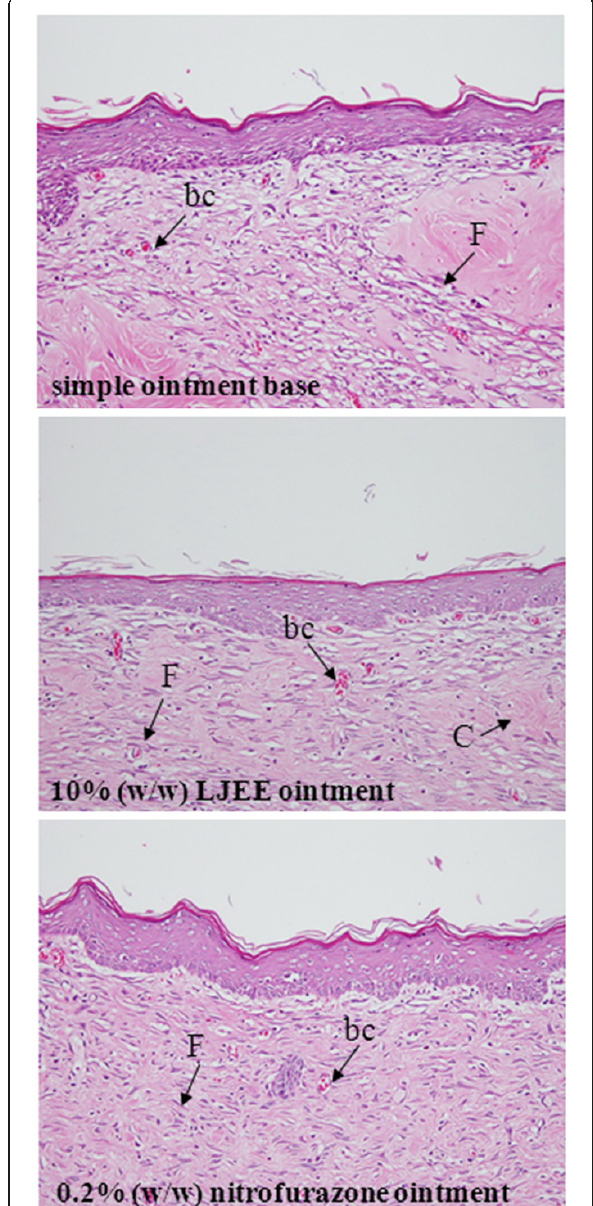
Figure 4 Histological examination of healed wound sections stained with H&E. The photomicrographs show healed wound sections isolated from rats treated with simple ointment base, 10% (w/w) LJEE ointment, or 0.2% (w/w) nitrofurazone ointment on day 15 after wounding. The photomicrographs were taken at a magnification of ×200. Abbreviation: bc, blood capillaries; C, collagen fibers; F, fibroblast. The histopathological scores of the healed wounds are presented in Table